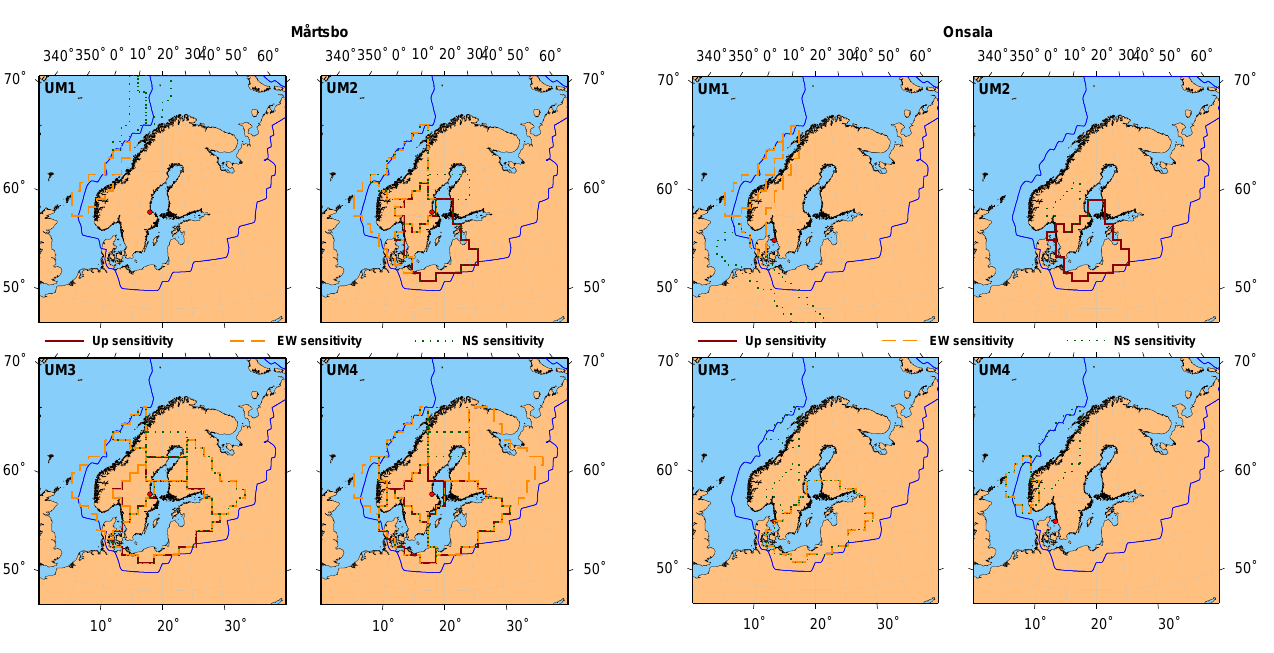
Fig.9. SameasFig.4,butforOnsala. Figure 9. Same as Fig. 4, but for Onsala.